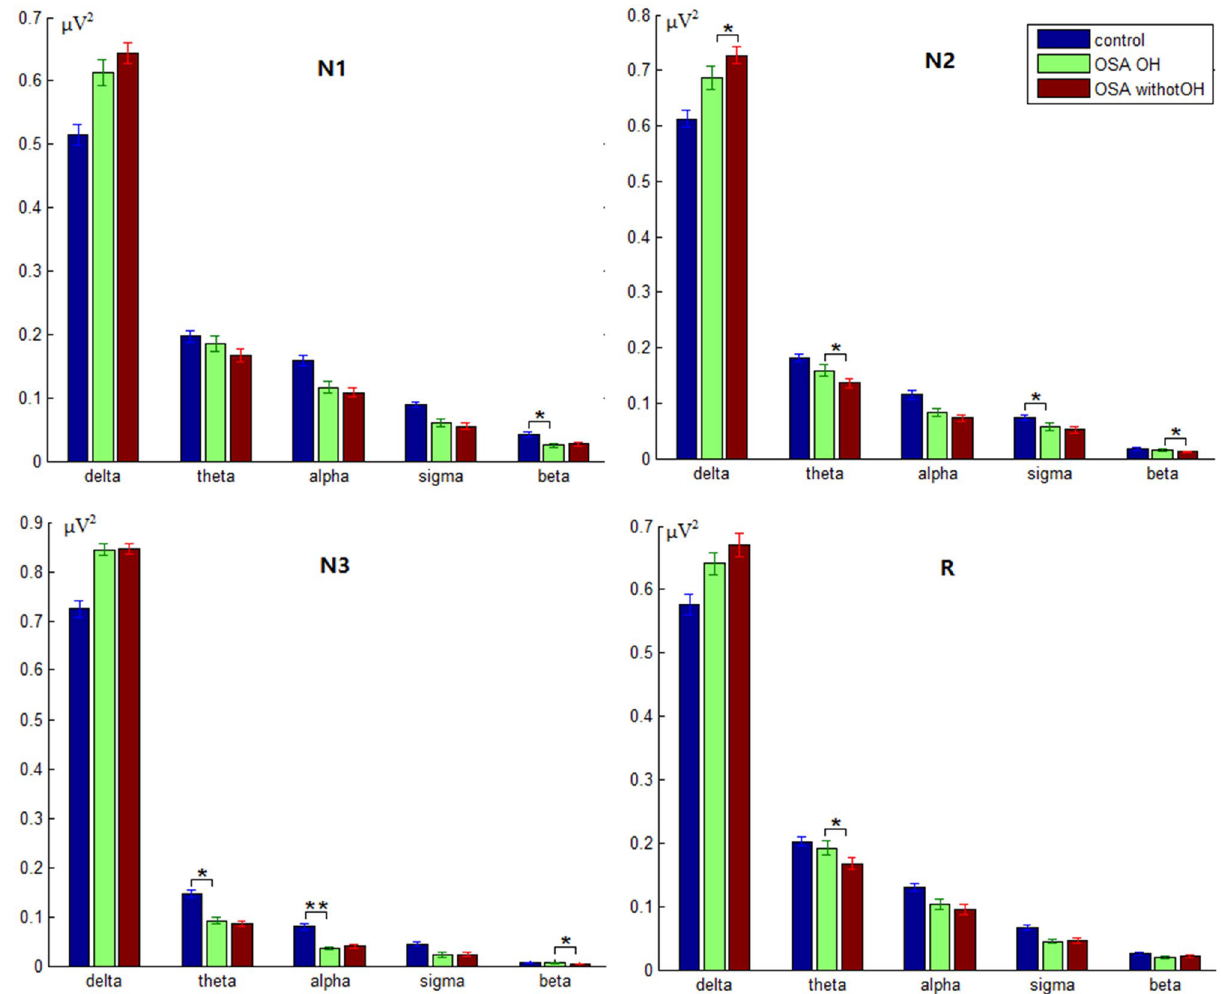
Figure 4. The delta, theta, alpha, sigma and beta power in four sleep stages in controls, OSA_OH and OSA_ withoutOH patients ( P* < 0.05, P** < 0.05).